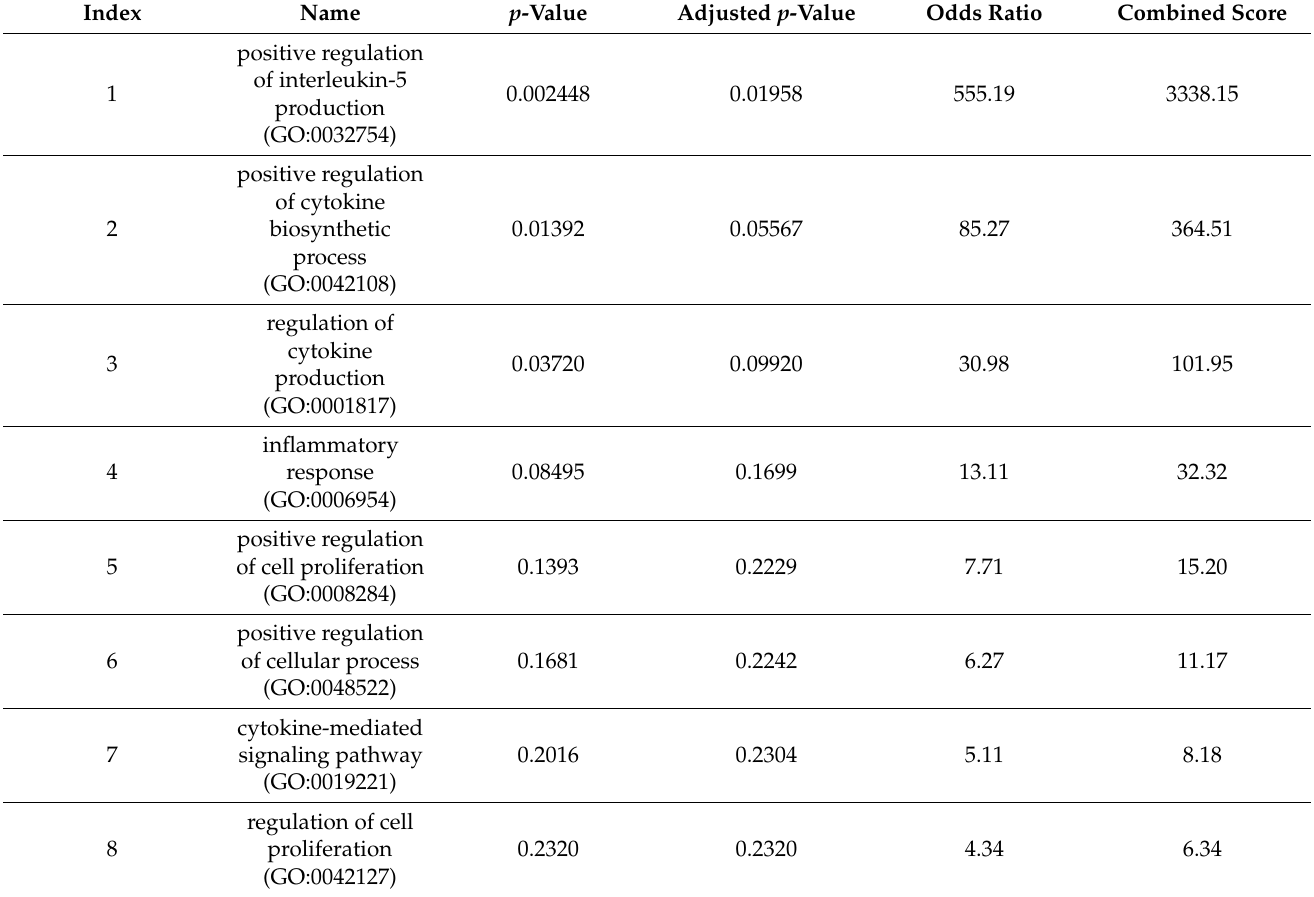
Table 1. Gene ontology analysis of the biological processes possibly linked to the inflammatory mediators (IL-2, IL-7, and IL-12p70) found over-expressed in the plasma of CBR individuals compared with age-matched OLD